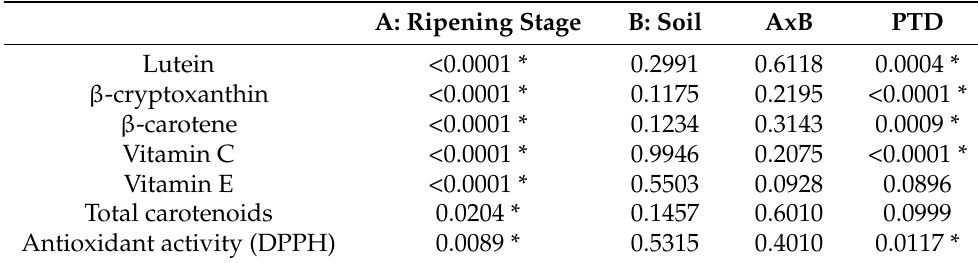
Table 3. p Values of the different factors evaluated and their respective interactions for each of the quantified carotenoids and